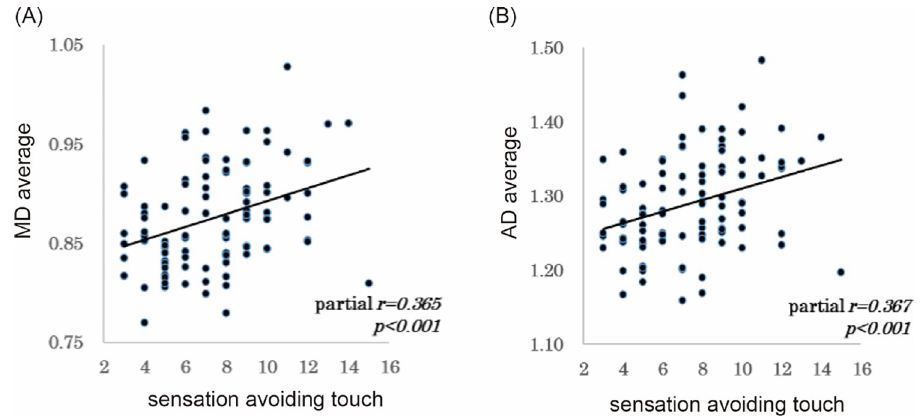
Fig 2. Correlation between the white matter fiber of the right caudate and AASP sub-score. A shows the correlations between MD of the white matter in the right caudate and the sensation avoiding touch score in AASP score (partial r = 0.365, p < 0.001). B shows the correlations between AD of the white matter in the right caudate and the sensation avoiding touch score in AASP score (partial r = 0.367, p < 0.001). B shows the correlations between MD of the white matter in the right caudate and the sensation avoiding touch score in AASP score (partial r = 0.365, p < 0.001). AD, axonal diffusivity; MD, mean diffusivity; AASP, Adolescent/Adult Sensory Profile.